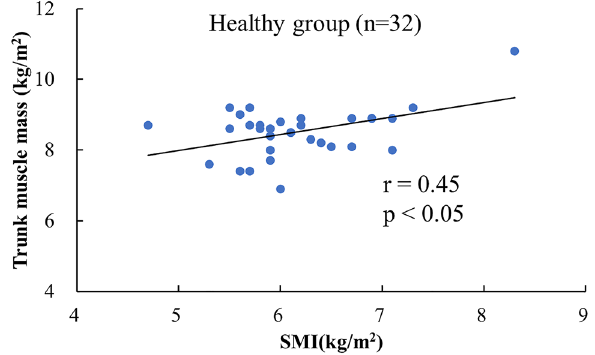
Figure 3. Correlation between SMI and trunk muscle mass in the healthy group. DHS Dropped head syndrome; SMI skeletal muscle mass